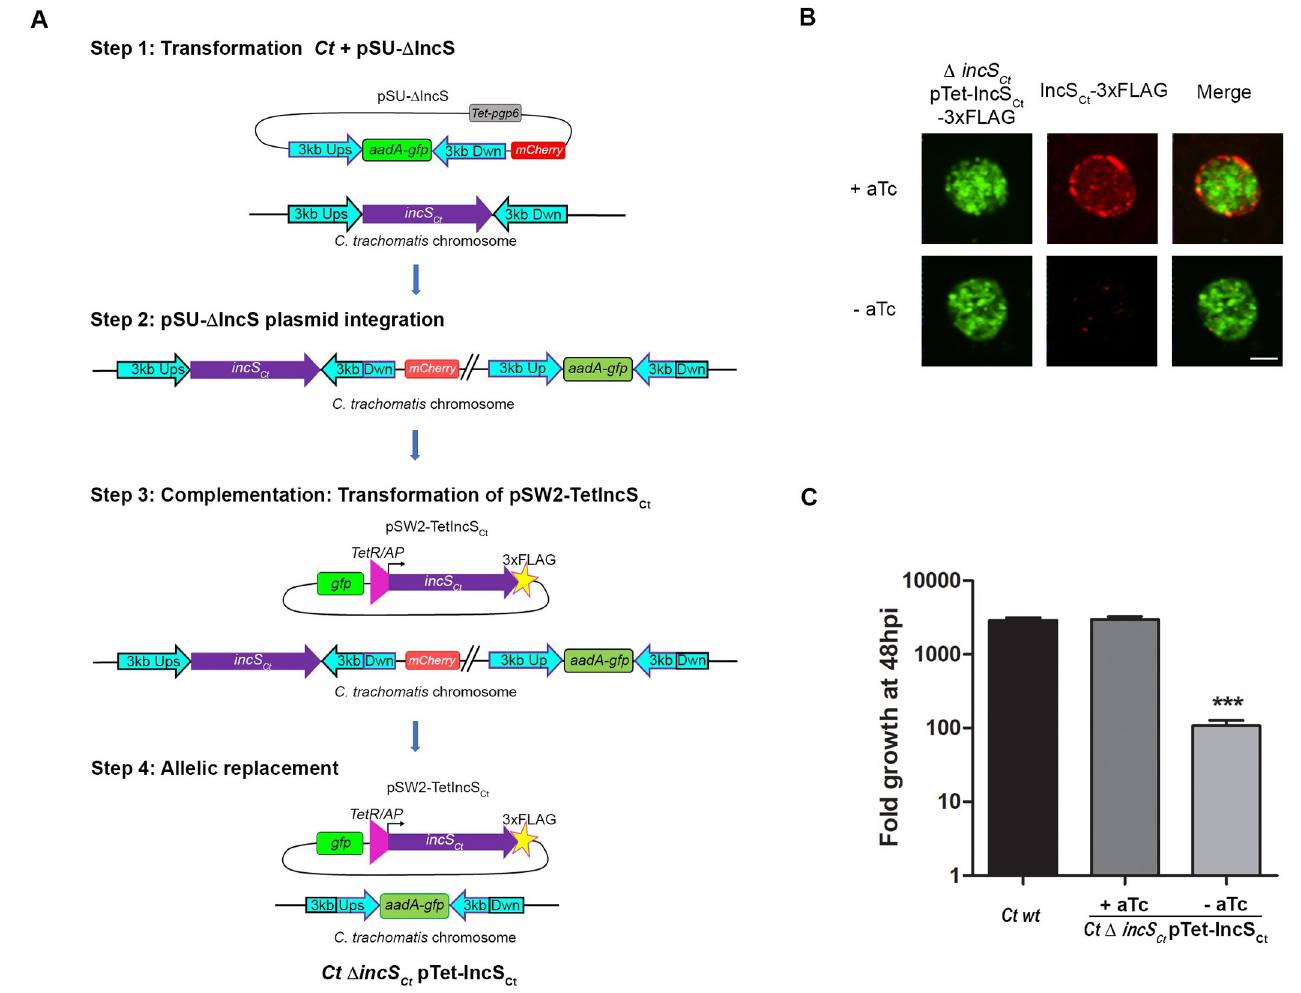
Fig 1. A Chlamydia trachomatis incS conditional mutant displays a severe growth defect in cell culture. (A) Schematic representation of the modified 4-step FRAEM strategy used to generate a C . trachomatis incS conditional mutant ( Ct Δ incS pTet-IncS Ct ). Step1: Transformation of wild-type C . trachomatis , Ct containing an intact chromosomal incS Ct ORF (purple), with pSU- Δ incS harboring ~3kb homology sequence upstream and downstream of the incS ORF (3kb Ups and 3kb Dwn, respectively, cyan) flanking the aadA-gfp selection cassette (green), mCherry (red), and the plasmid maintenance ORF pgp6 under the control of the aTc inducible promoter (gray). Step 2: Integration of pSU- Δ incS in the C . trachomatis chromosome upstream or downstream (shown here) of the incS ORF, via a single recombination event, resulting in a strain displaying dim green and red fluorescence. Step 3: Transformation of the strain resulting from step 2 with pSW2-Tet-IncS Ct , a complementation plasmid encoding GFP (green) and a 3x-FLAG tagged (yellow star) allele of IncS Ct (purple) under the control of the aTc inducible promoter (TetR/AP, pink triangle). Step 4: Expression of IncS from the complementation plasmid, allows for allelic replacement of the chromosomal incS ORF with the aadA-gfp cassette and loss of mCherry, via a second event of recombination within the 3 kb upstream sequence. (B) Three- dimensional confocal micrographs of HeLa cells infected for 24h with the C . trachomatis Δ incS Ct conditional mutant expressing GFP ( Δ incS Ct pTet-IncS Ct - 3xFLAG, left panels, green) in the presence (+aTc, top panels) or the absence (-aTc, bottom panels) of aTc and stained with anti-FLAG antibody (IncS Ct - 3xFLAG, middle panels, red). The merge is shown on the right. Scale bar: 5 μ m. (C) Fold growth of wild-type C . trachomatis ( Ct wt ) and the C . trachomatis Δ incS Ct conditional mutant ( Δ incS Ct pTet-IncS Ct ) in HeLa cells at 48h pi compared to 0h pi in the presence (+aTc) or absence (-aTc) of aTc. Data are mean ± SEM, three combined experiments, One-way ANOVA, Tukey’s Multiple Comparison Test, ��� P < 0.001 (-aTc vs + aTc or